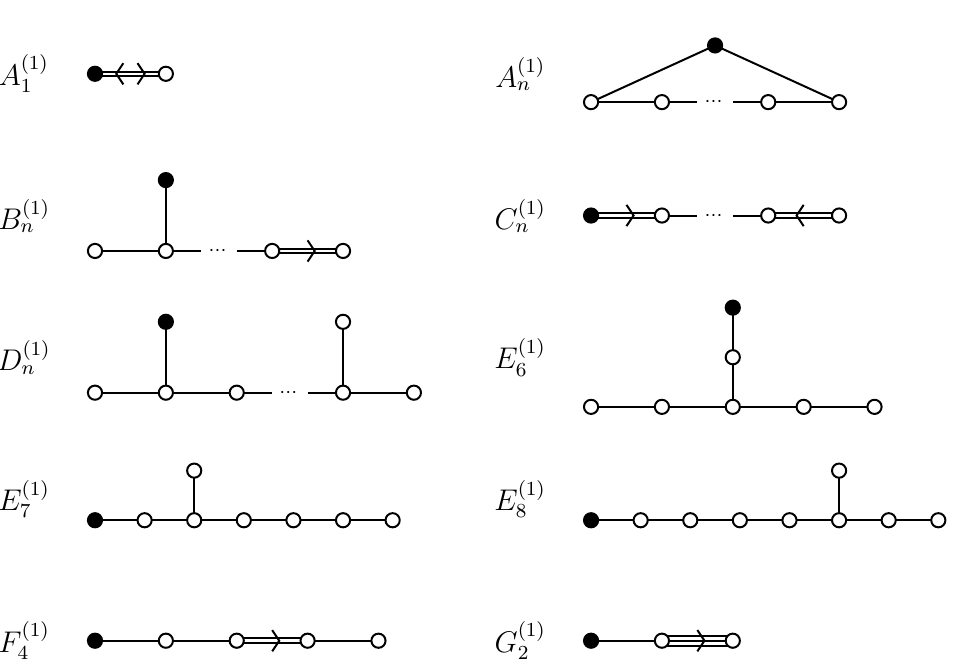
Figure 18. Dynkin diagrams of untwisted affine Lie algebras, where the black node • represents the affine